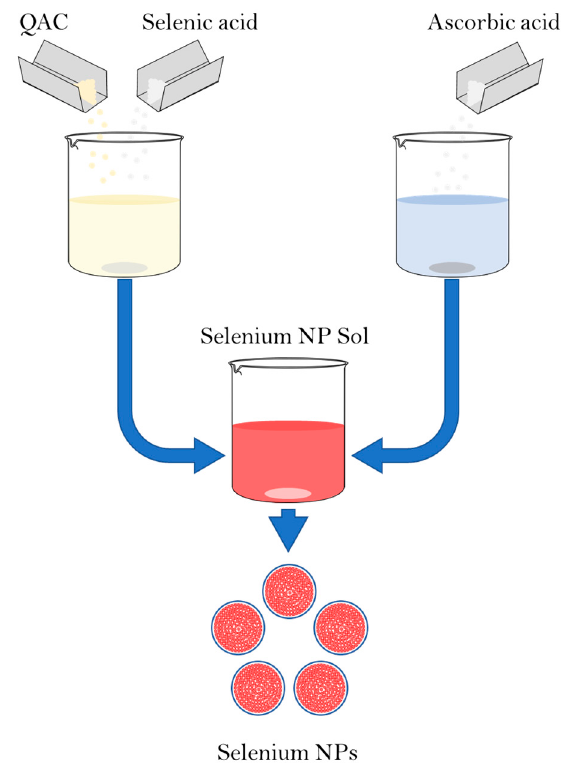
Figure 1. Scheme of synthesis of Se NPs stabilized with alkyldimethylbenzylammonium chloride (catamine AB).